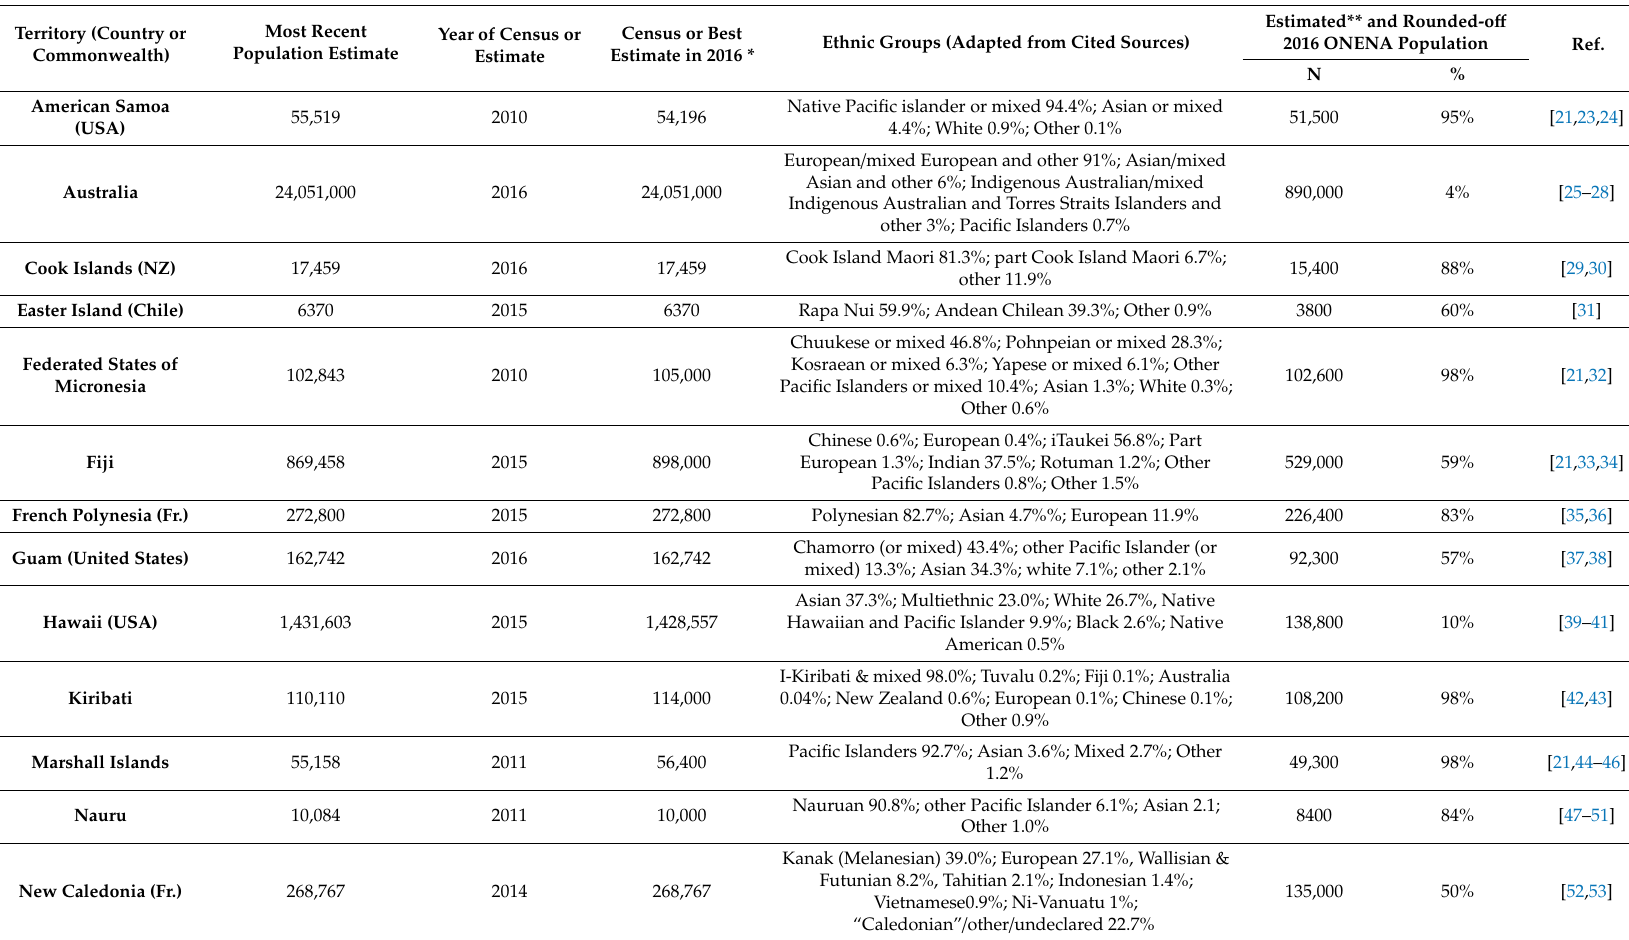
Table 1. Estimates of total populations and of population subgroups considered / self-declared as descending entirely or in part of ONENA populations, Oceania, 2016. Territory (Country or